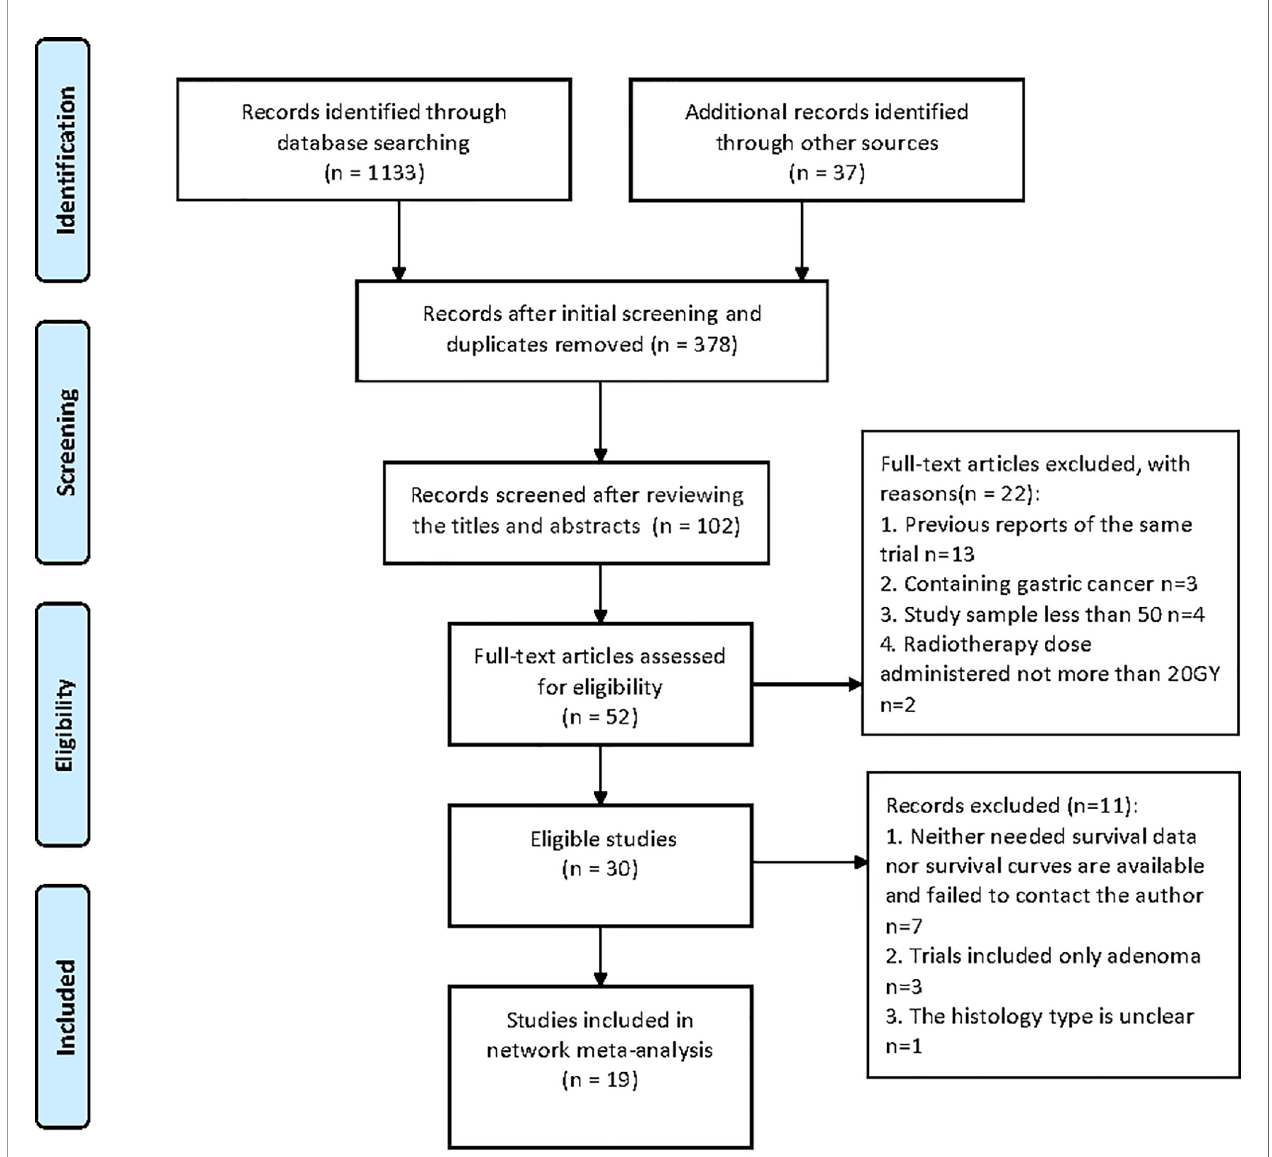
FIGURE 1 | Literature search/PRISMA fl ow